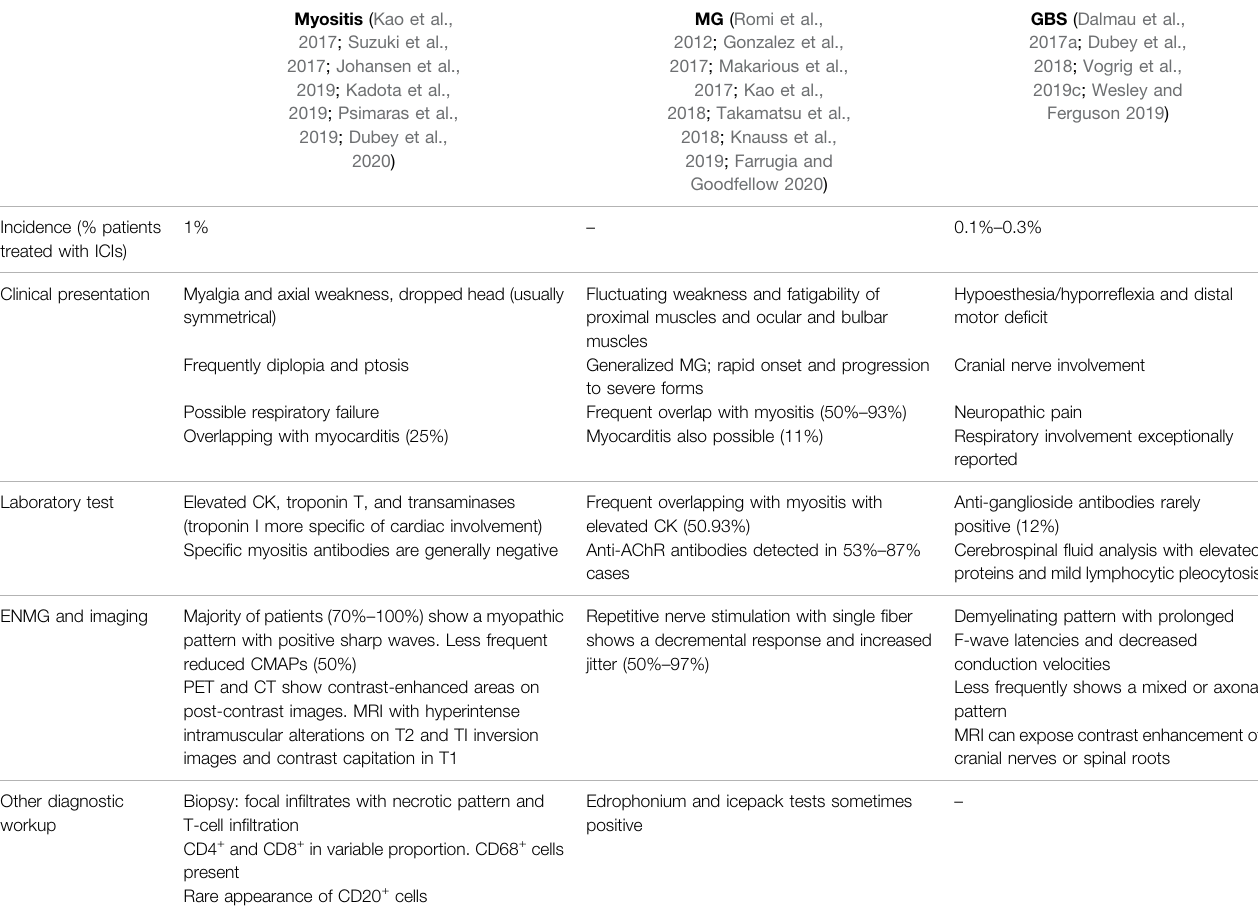
TABLE 1 | Clinical presentation of the main ICI-related peripheral neurological